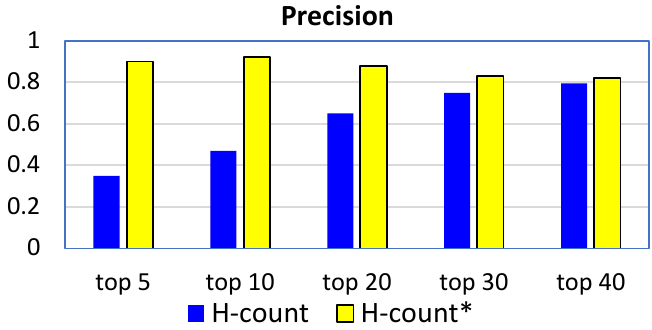
Figure 5. Precision comparison between H-Count and H-Count*.